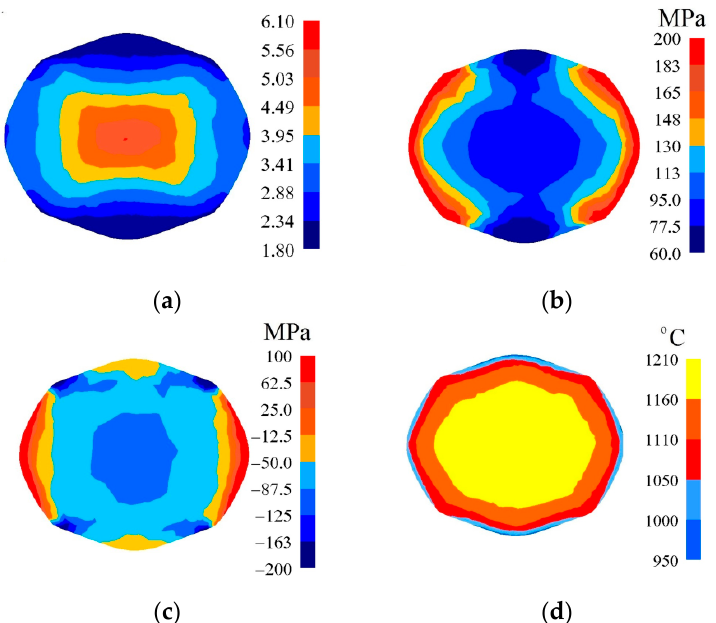
Figure 15. Distribution of the effective strain ( a ), effective stress ( b ), mean stresses ( c ), and temperature ( d ) after the fourth pass of the forging with a concave cross-section in V-shaped anvils ( α c = 150°, ε c = 0.356, forging ratio 4.2).